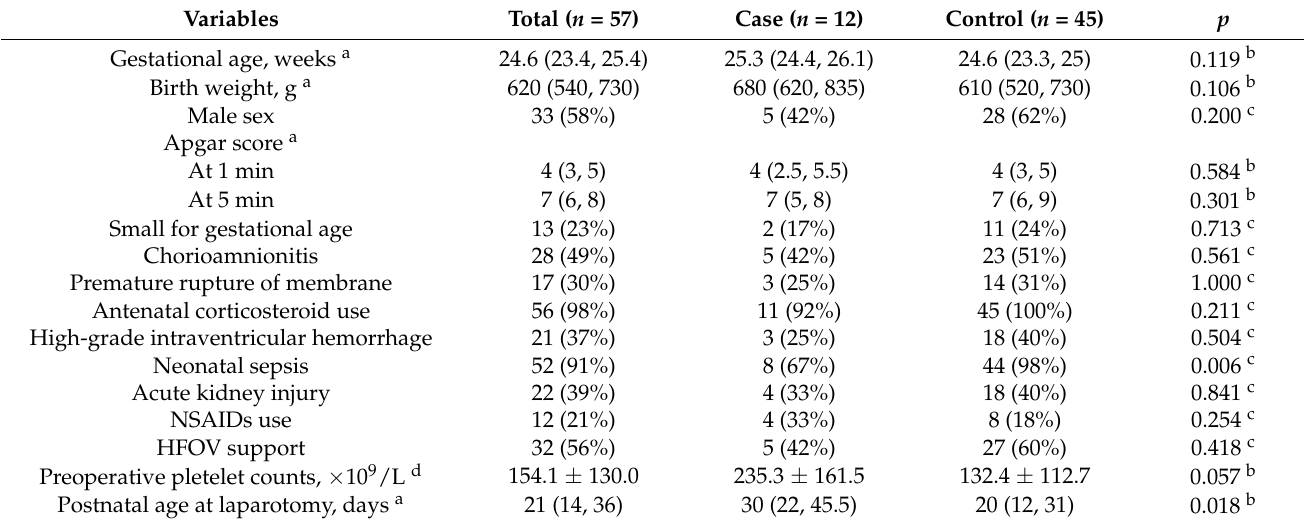
Table 1. Demographics and clinical characteristics for study